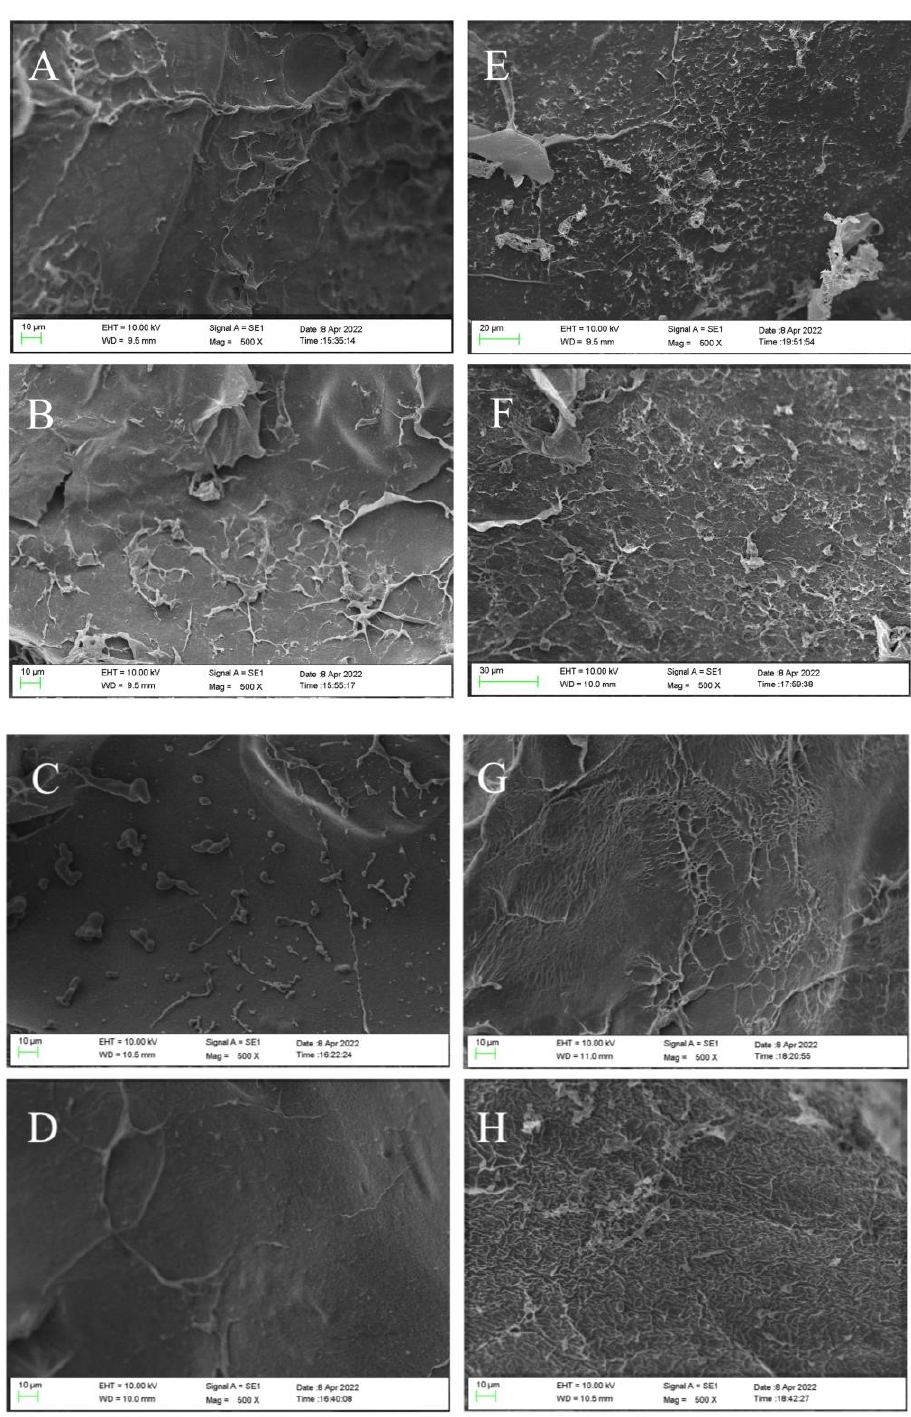
Figure 2. SEM micrograph of surface morphology before absorption of CV SFP/SA-0 ( A ), SFP/SA- 60 ( B ), SFP/SA-40 ( C ), and SFP/SA-60 ( D ) and after absorption of CV SFP/SA-0 ( E ), SFP/SA-20 ( F ), SFP/SA-40 ( G ), and SFP/SA-60 ( H ) at